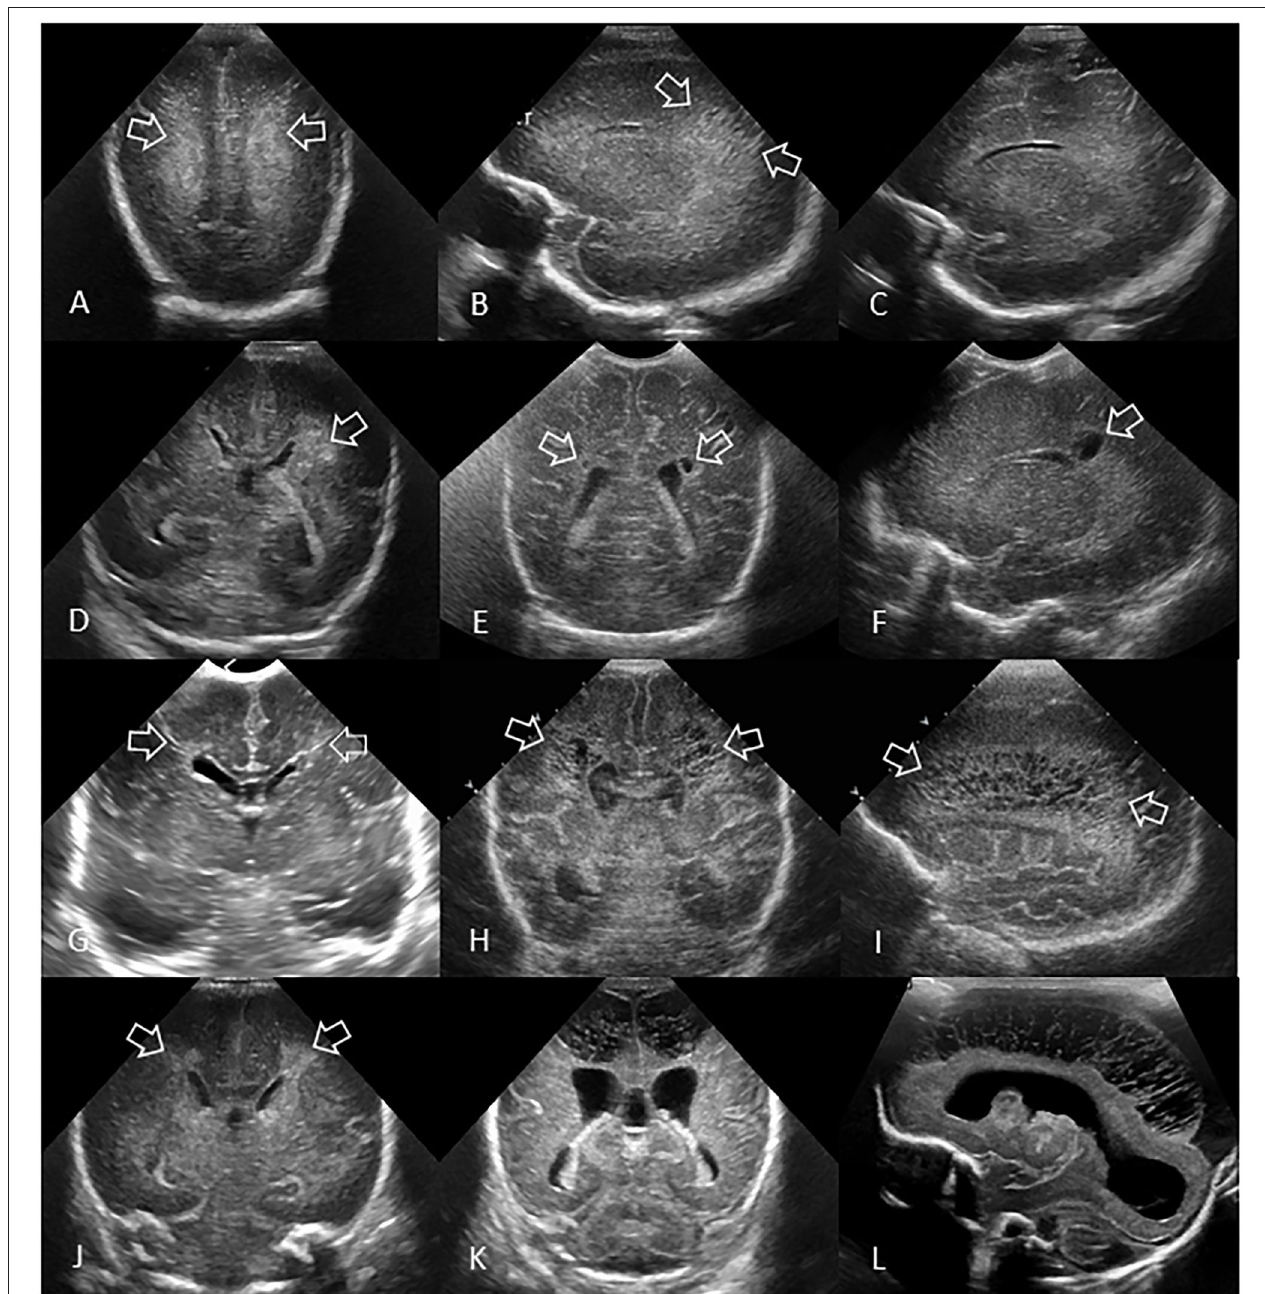
FIGURE 7 | Spectrum of ischemic white matter injury. (A–C) Grade 1 WMI. Ultrasound scan in a preterm infant (GA 26 weeks) with transient abnormal white matter echodensities. (A,B) Coronal and left parasagittal scans show inhomogeneous moderately increased echogenicity (“flaring” or PVE) of the parietal periventricular white matter (arrows). No IVH. (C) Parasagittal scan 5 weeks later shows full resolution of the echodensities. White matter echogenicity is now homogeneous and normal, and no cysts developed. (D–F) Grade 2 WMI. Ultrasound scan in a preterm infant (GA 27 weeks). (D) Coronal scan at the level of the body of the lateral ventricles shows asymmetric inhomogeneous PVE (“flaring”) in the left parietal periventricular white matter (arrow). (E,F) Coronal and left parasagittal scans 9 weeks later showing small localized cystic lesions in the fronto-parietal white matter of both hemispheres (arrows). The tiny, right-sided cysts developed despite any convincing increased white matter echogenicity detected on early cUS exams. (G–I) Grade 3 WMI. Ultrasound scan in a preterm infant (GA 30 weeks with giant omphalocele partially repaired at day 4 of birth) with significant WMI. (G) Coronal scan 3 days after birth, at the level of the frontal horns of the lateral ventricles, shows only limited patchy areas of echodensity (arrows) not with certainty distinguishable from physiologic frontal echogenic areas in the periventricular white matter. No IVH. (H,I) Coronal and left parasagittal scans 4 weeks later show evolution of the WMI with extensive cystic lesions extending from the frontal white matter to the posterior parietal white matter (arrows) not expected by the only limited patchy echogenicity seen on day 3. The subcortical white matter is not involved. Dilated ventricles are